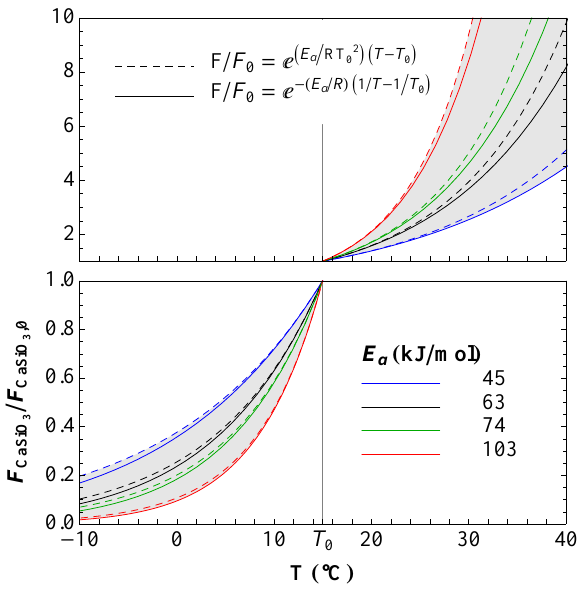
Fig. 5. Effects on silicate weathering-temperature feedback of changing activation energy ( E a , different colours), and simplifying Equation 7 (solid lines) to Equation 8 (dashed lines). Values for E a are taken from (West et al., 2005) (74 ± 29 kJ/mol) and (Brady, 1991) (63 kJ/mol). Note that lower activation energies give bigger fluxes for T < T 0 (bottom panel, different y -axis scale).